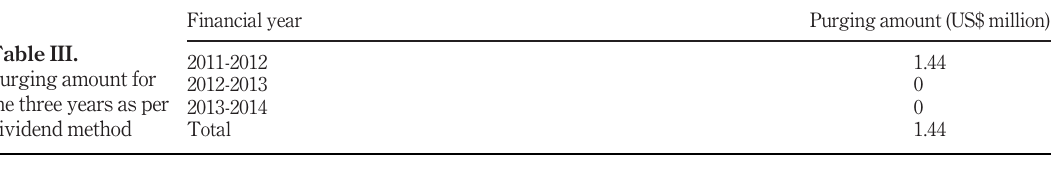
Table IV. Purging amount for the three years as per AAOIFI